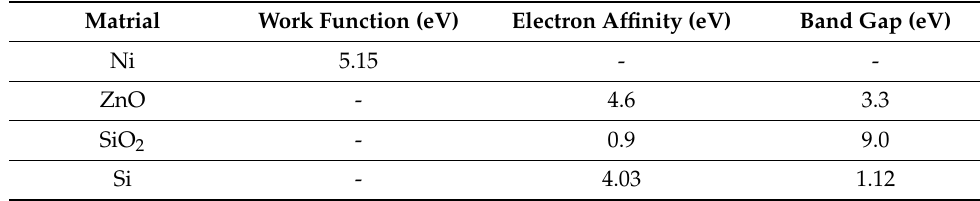
Figure 2. Schematics of possible conducting filament model. ( a ) initial state. ( b ) set process. ( c ) LRS. ( d ) reset process. ( e ) HRS. Simple energy band diagram. ( f ) Work function and energy gap of each layer. ( g ) set process. ( h ) reset process. Table 1. Material parameters for Ni/ZnO/SiO 2 /Si